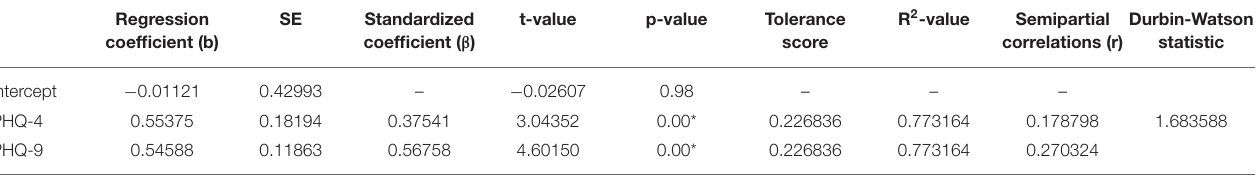
TABLE 6 | Multiple linear regression model with the GAD-7 as the dependent variable and PHQ-4 and PHQ-9 as independent variables. Regression coefficient (b)